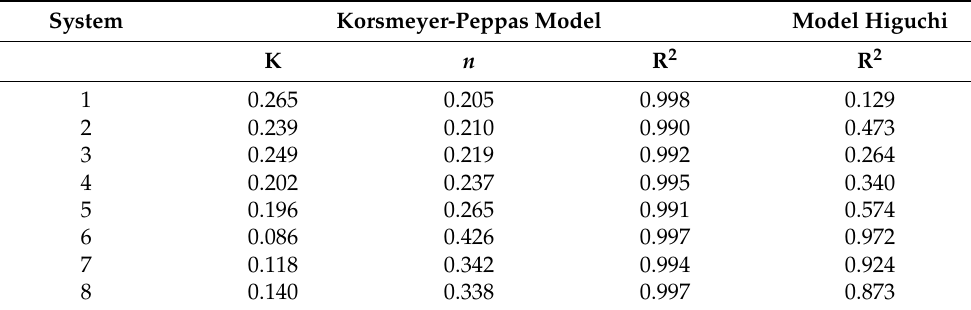
Table 8. The values of the determination coefficients R 2 and the release exponent n, determined by applying the Korsmeyer-Peppas and Higuchi mathematical models.